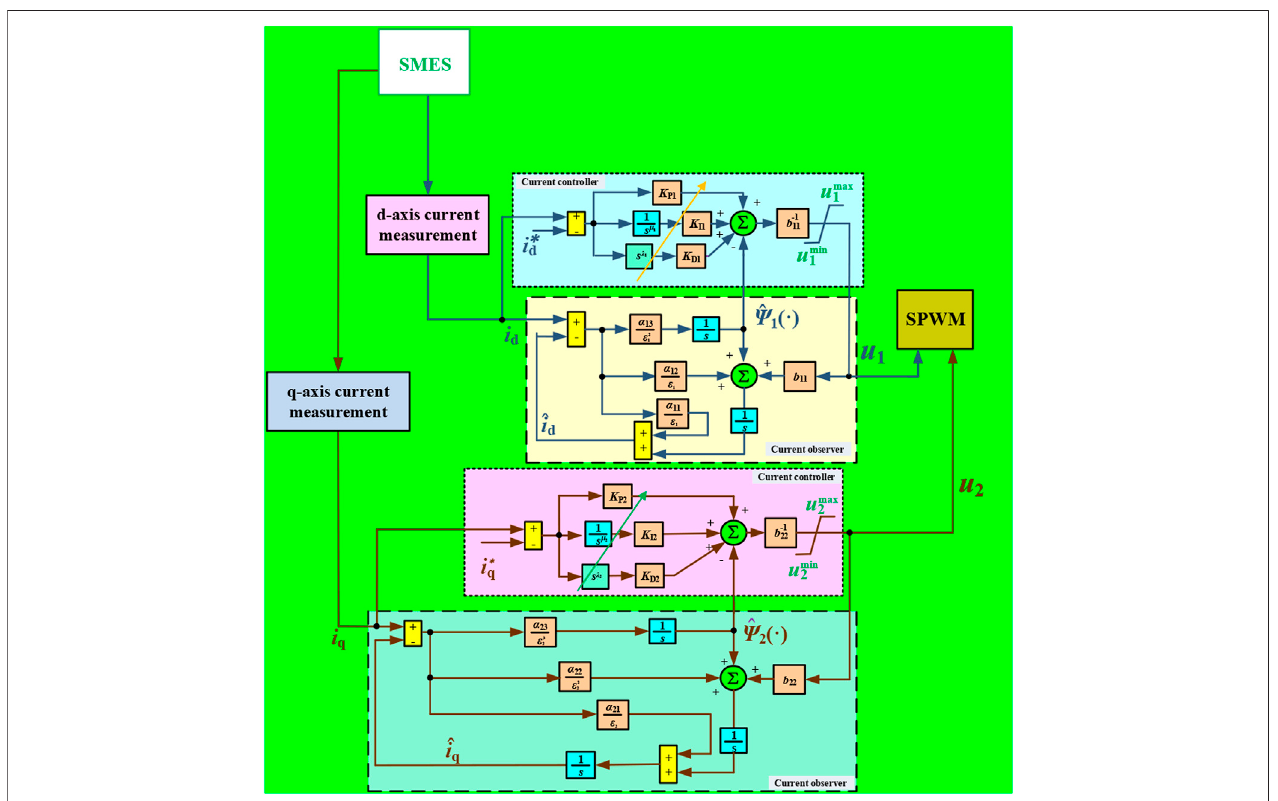
FIGURE 6 | The overall control framework of a perturbation observer-based fractional-order control (POFOC).